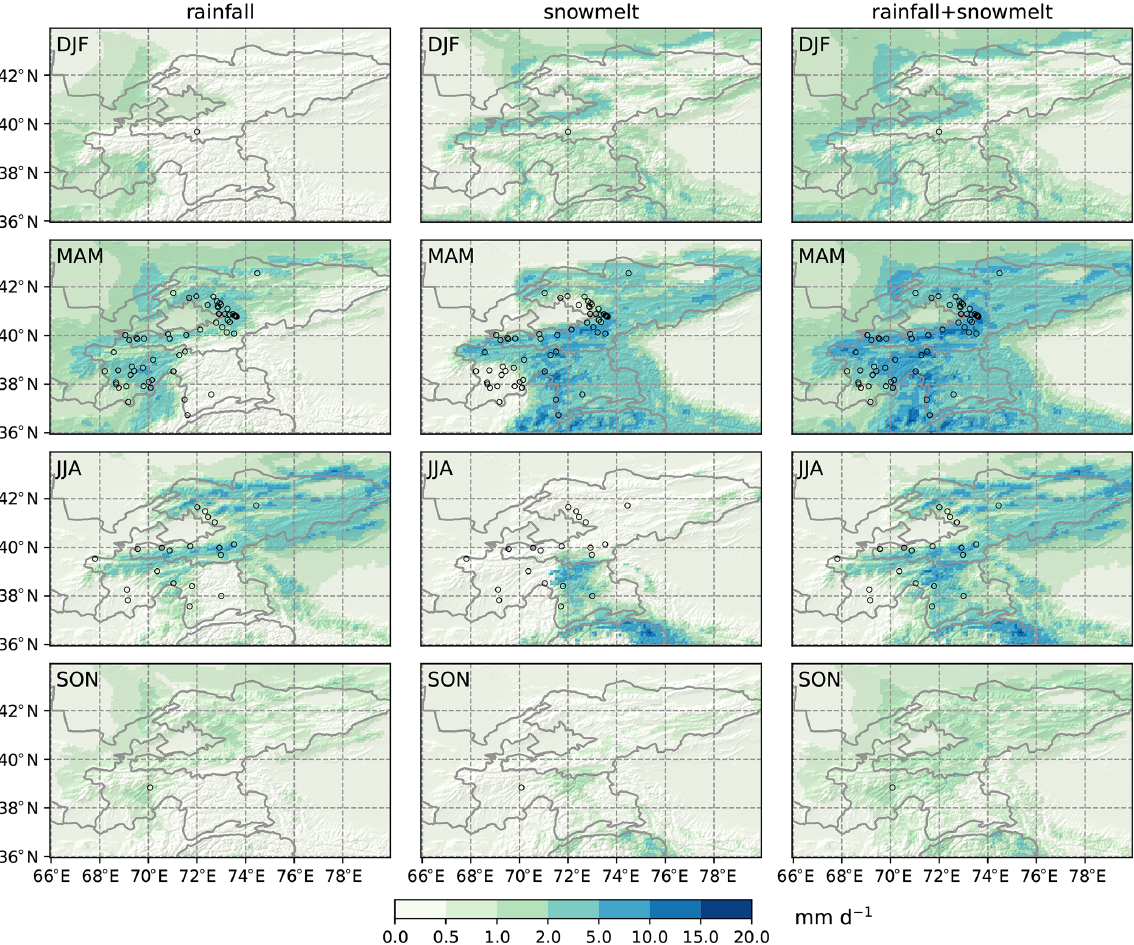
Figure 2. Seasonal rainfall, snowmelt, and rainfall + snowmelt from the HAR v2 from 2004 to 2018. Black circles: seasonal landslide events from the GLC and the GFLD. Topographic shading is based on DEM data from SRTM. DJF: December–February; MAM: March–May; JJA: June–August; and SON: